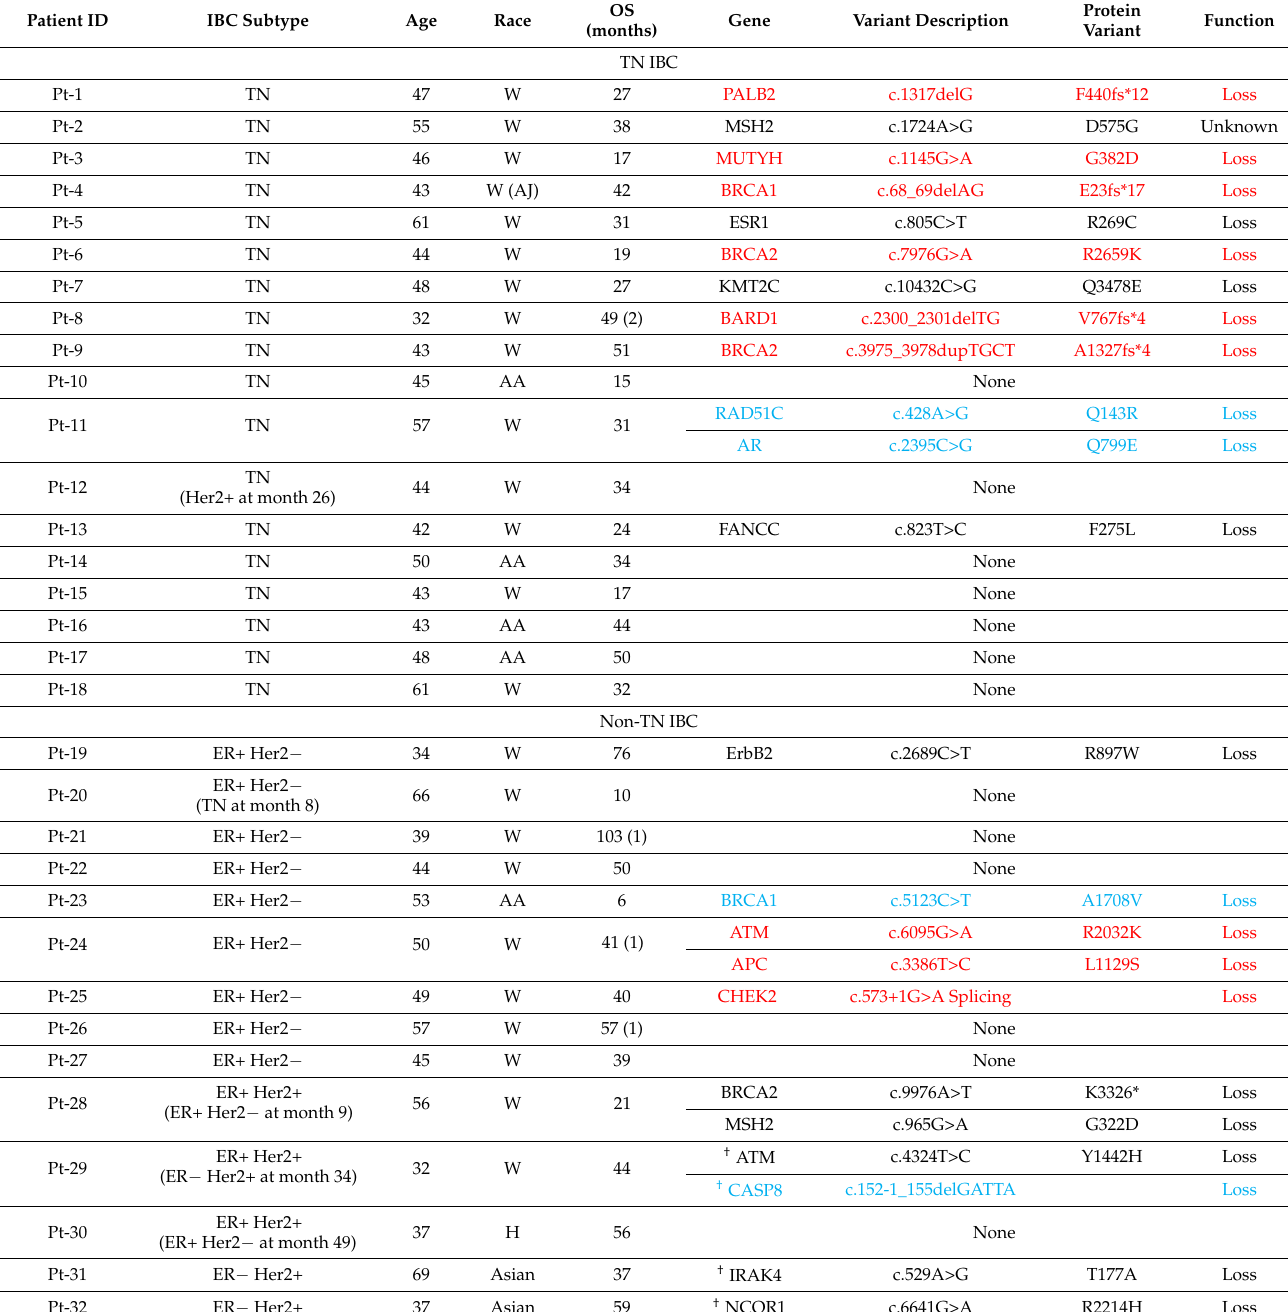
Table 1. Demographics and germline variants in IBC patients. IBC subtype, age at onset of the disease, race, overall survival (OS), and germline variants are indicated. Germline pathogenic (red), likely pathogenic (blue), and variants of uncertain significance (black). Normal tissue or whole blood samples were available for 20 patients (Pt-1 to Pt-15, Pt-19, Pt-20, Pt-21, Pt-24, and Pt-28) to confirm germline variants. † Putative germline variants. (1) Patient alive; (2) last record available. * Stop codon. Abbreviation: W, white; AA, African American; H, Hispanic; AJ, Ashkenazi Jewish heritage; TN, triple